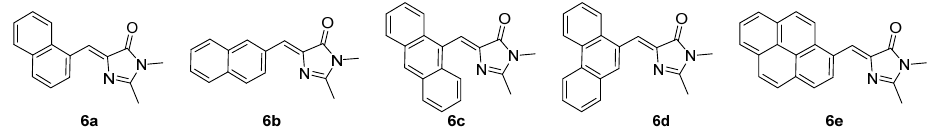
Figure 6. GFPc analogues with large aromatic substituents [20].